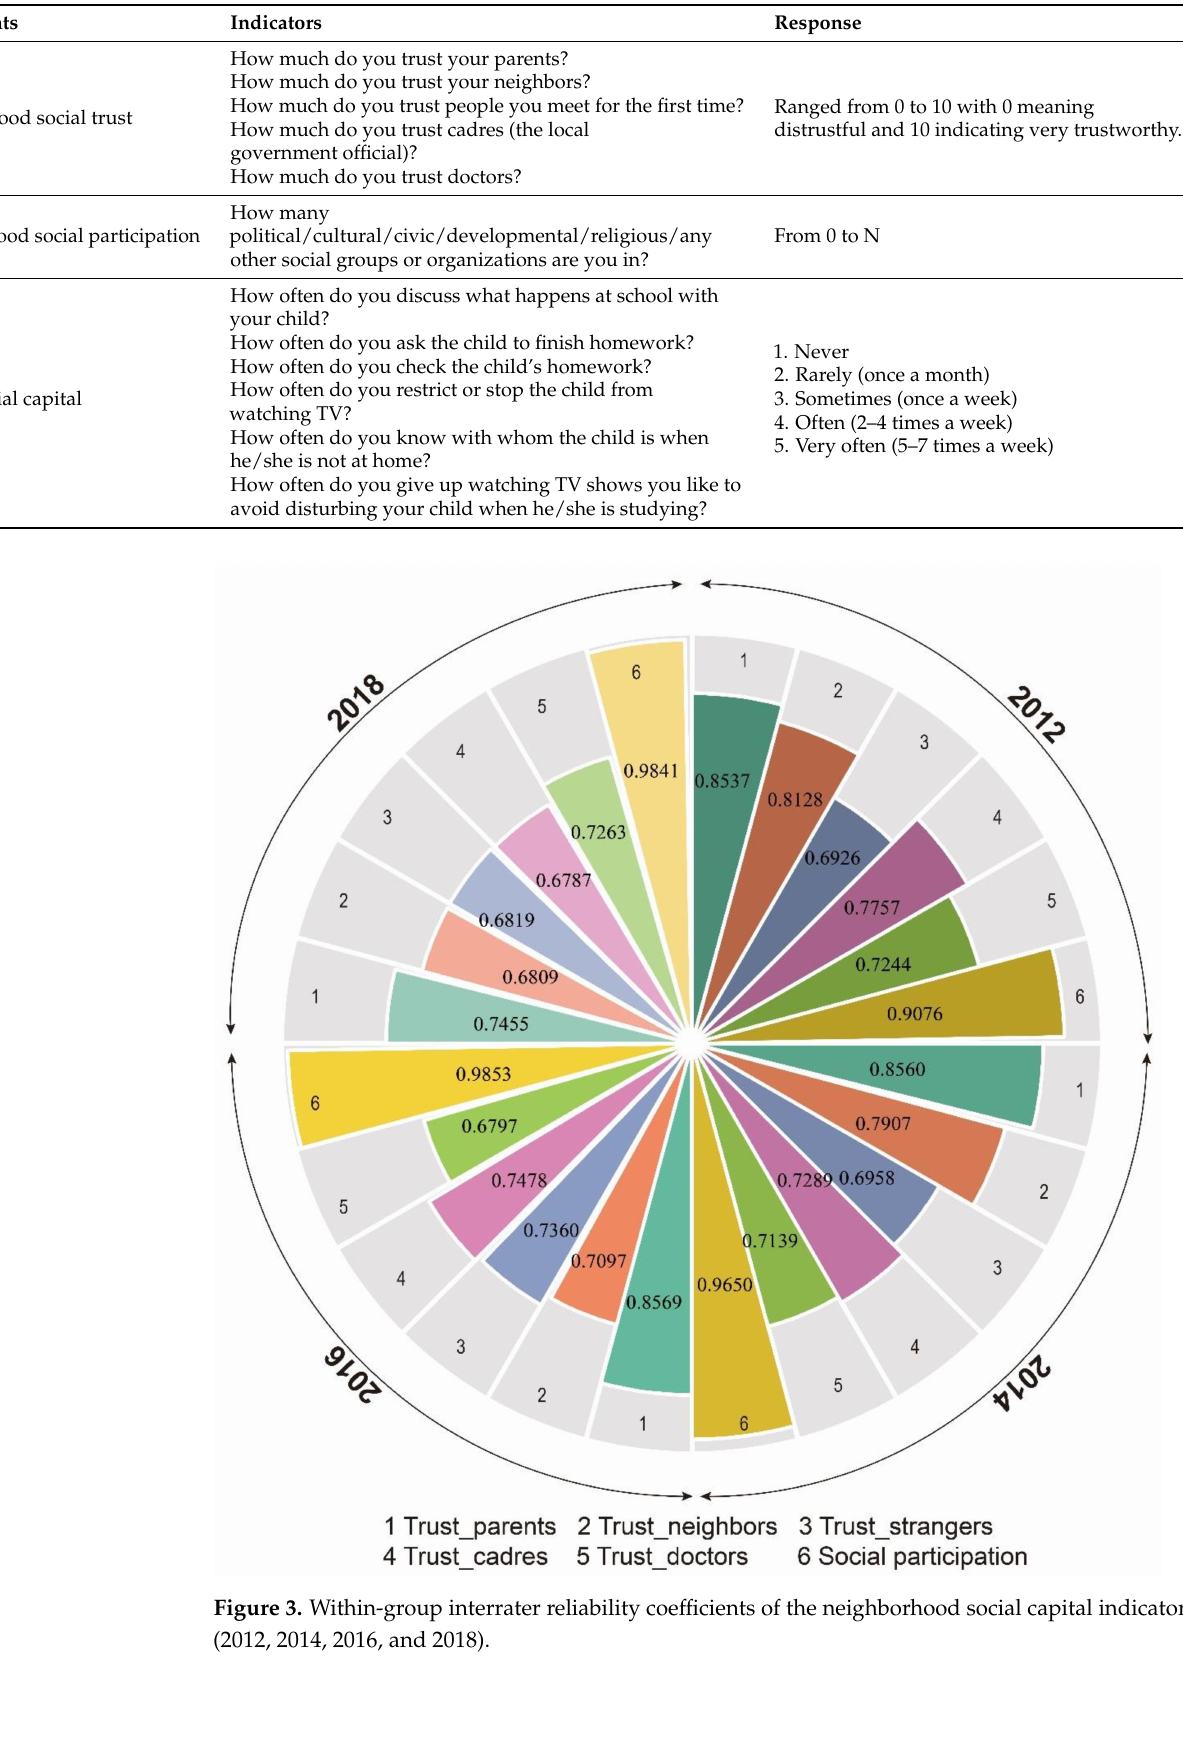
Table 3. Survey items of the neighborhood and family social capital components.